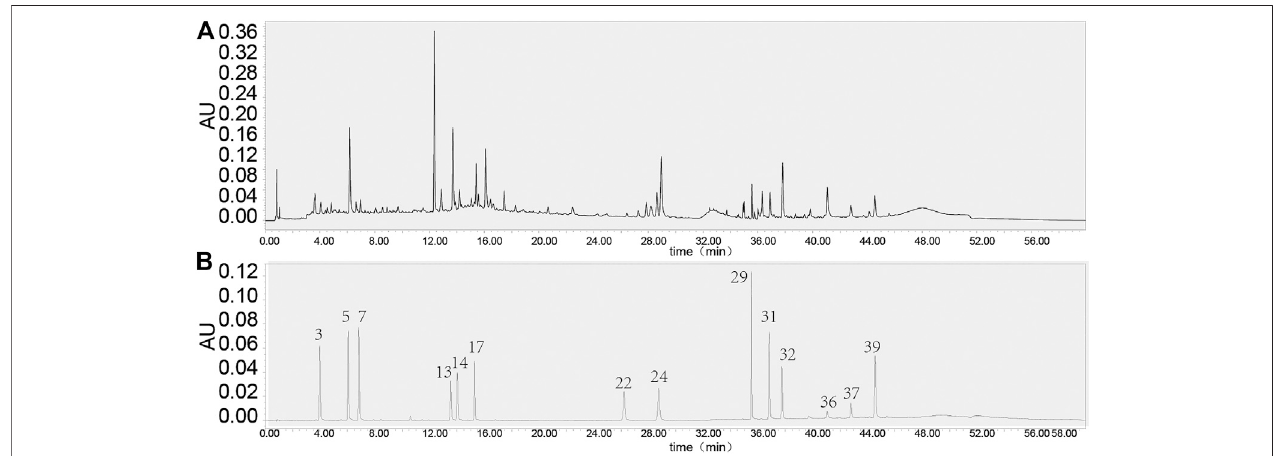
FIGURE 6 | UPLC of BZBS (A) and Reference substance [ (B) , mixed reference substance]. The BZBS detection method is shown as a Supplementary method. Compound13.Isoquercitrin;compound14.Hyperoside;compound17.Verbascoside;compound22.EpimedinsA;compound24.Icariin;compound29.Baohuoside I; compound 31. Imperatorin; compound 32. Osthole; compound 36. Catalpol; compound 37. Deoxyschizandrin; 39.Schisandrin